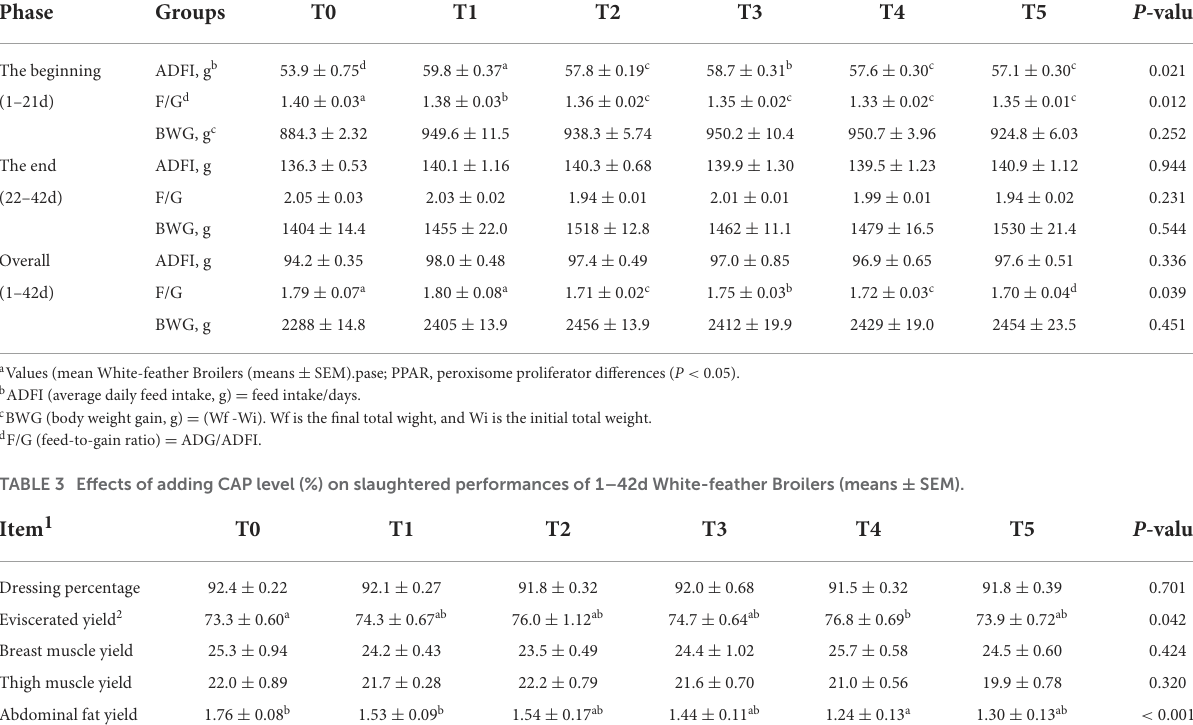
TABLE 2 Effects of adding CAP level on growth performance of White-feather Broilers (means ± SEM). Phase